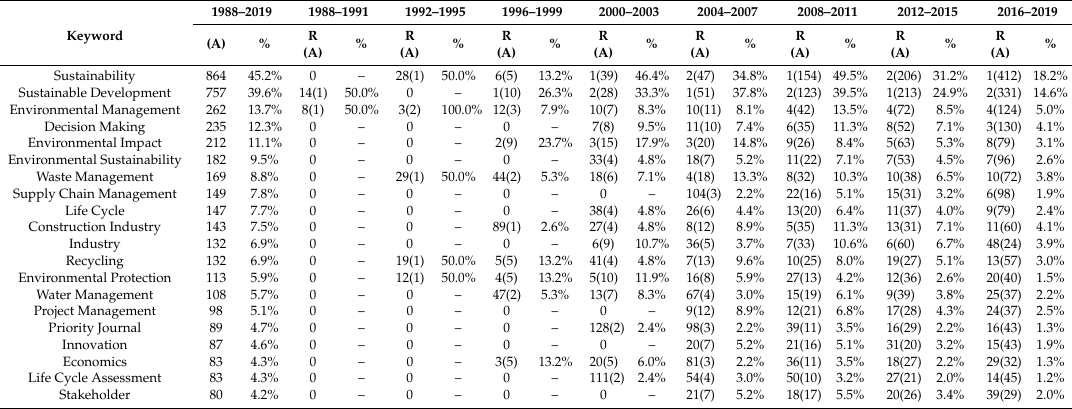
Figure 6 represents the keywords network map of the 1911 articles on the research topic.